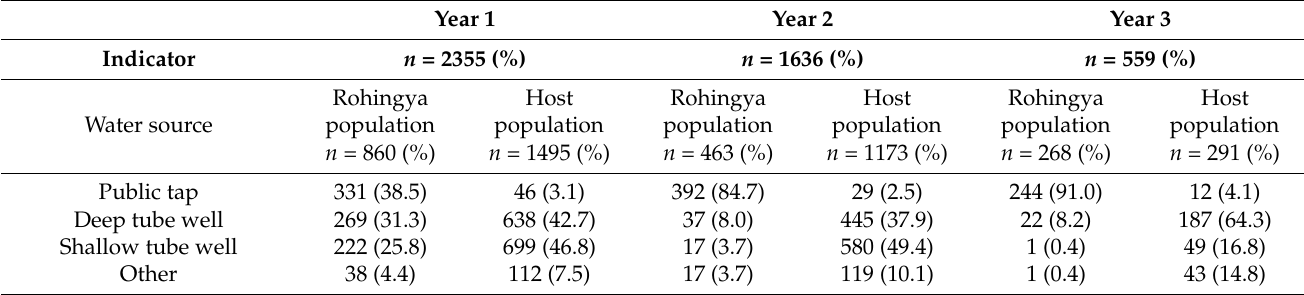
Table 2. Changing trend showing water source used by the Rohingya population and neighbor- hood host-country population over three years in the Teknaf and Ukhia sub-districts, Cox’s Bazar, Bangladesh 2018–2021.